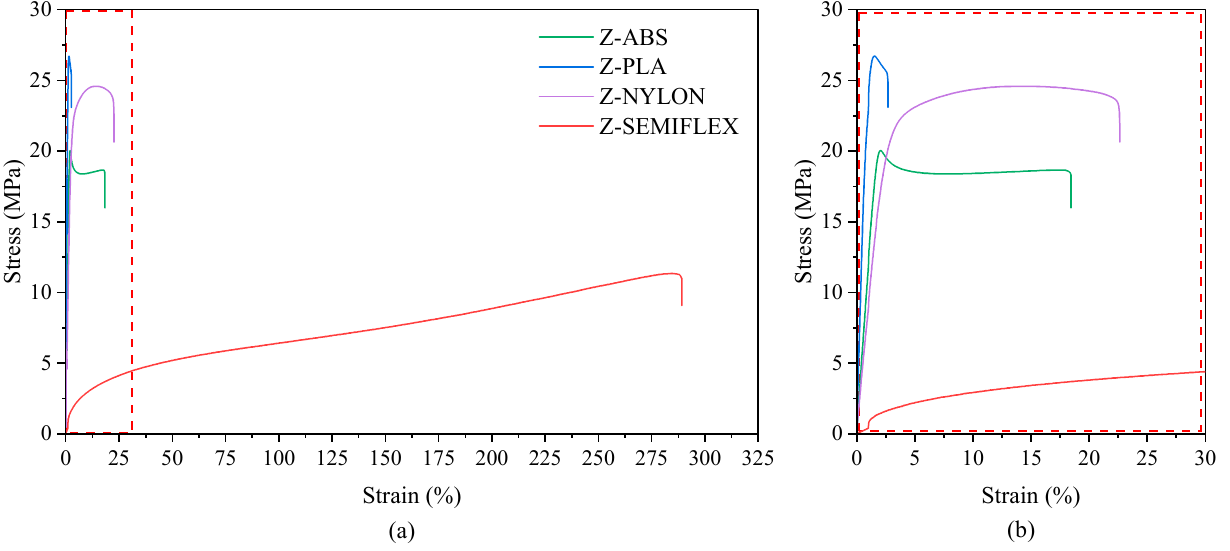
Figure 5. Representative stress–strain curves of Z-ABS, Z-PLA, Z-NYLON and Z-SEMIFLEX ( a ), together with an enlarged view of the small elongation range ( b ). Table 6. Tensile properties of investigated